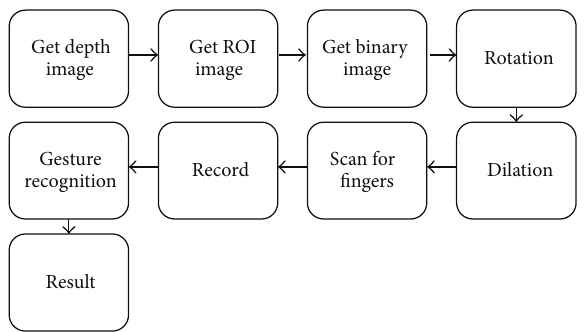
Figure 6: Finger gesture recognition